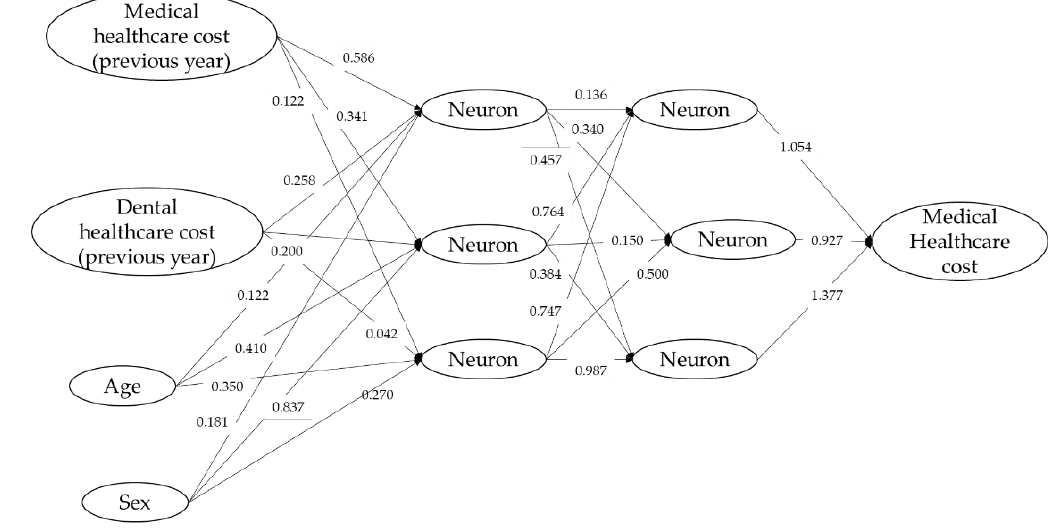
Figure 4. Neural network model for the prediction of medical healthcare cost.